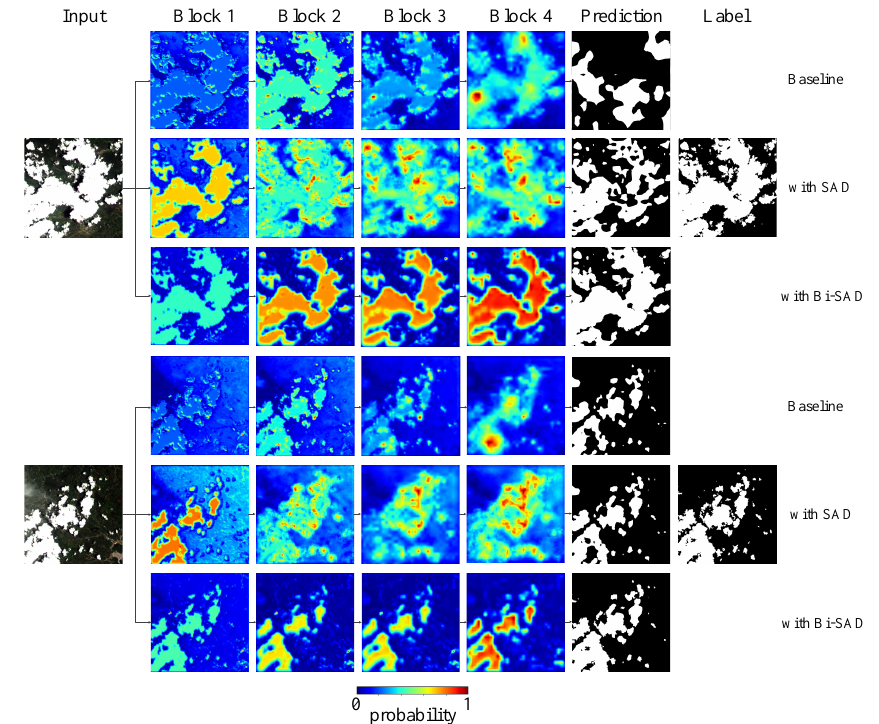
Figure 9. Predictions and attention maps of baseline model with and without self-attention distillation. When Bi-SAD is added to baseline model, the shape of attention maps and clouds are more similar, and the predictions are more